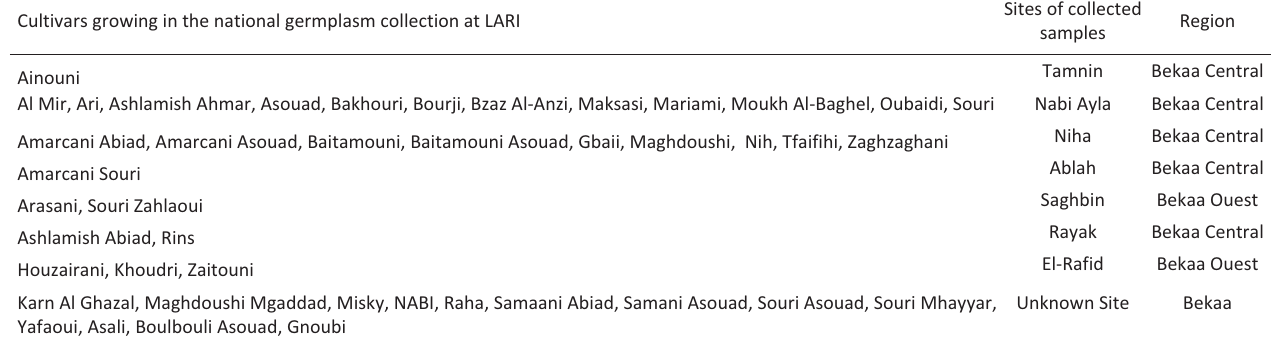
Table 1 ­ Sites of 43 collected samples of traditional cultivars grapevine growing in the national germplasm collection at the Lebanese Agricultural Research Institute (LARI­Tal Amara) Cultivars growing in the national germplasm collection at LARI